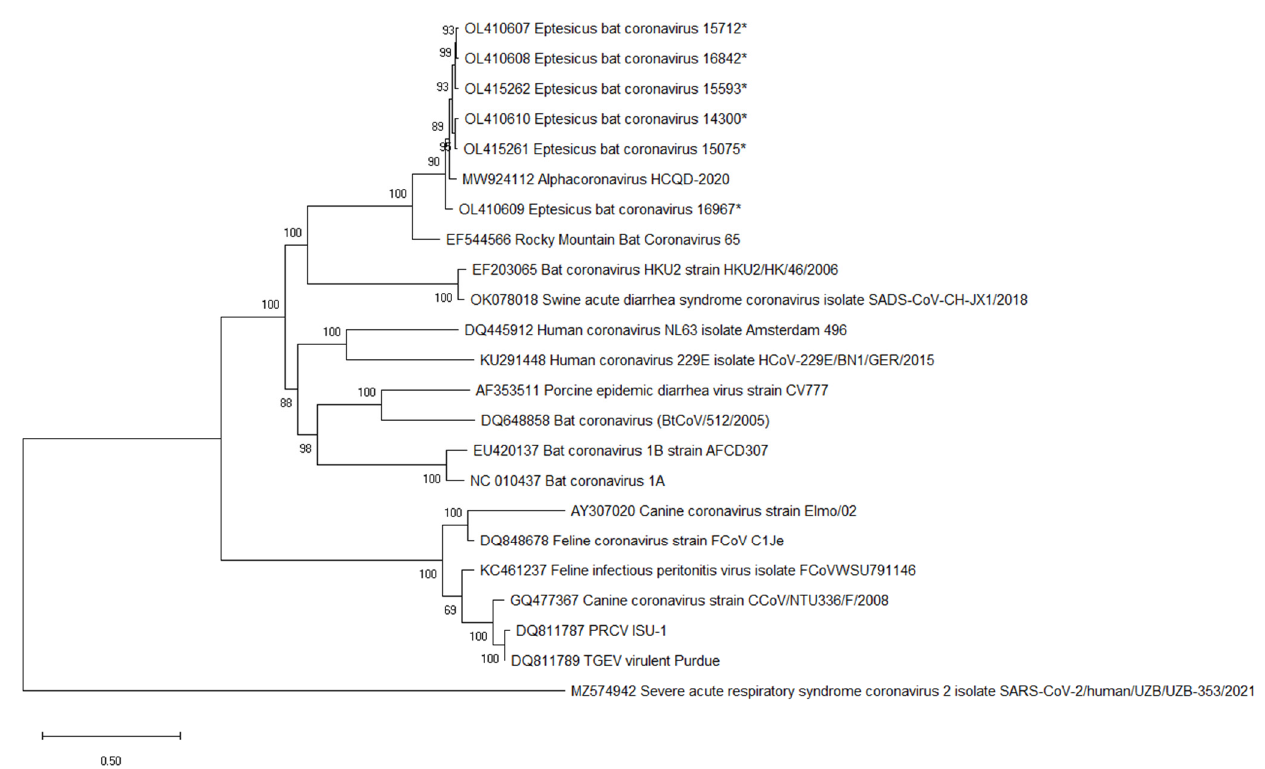
Figure 3. Phylogenetic analysis of complete genome sequences was performed in MegaX using the maximum likelihood method along with a GTR + G substitution model [21,22]. The bootstrap values were calculated from 500 replicates, and values greater than 70 are shown. Sequences determined here are indicated by *.